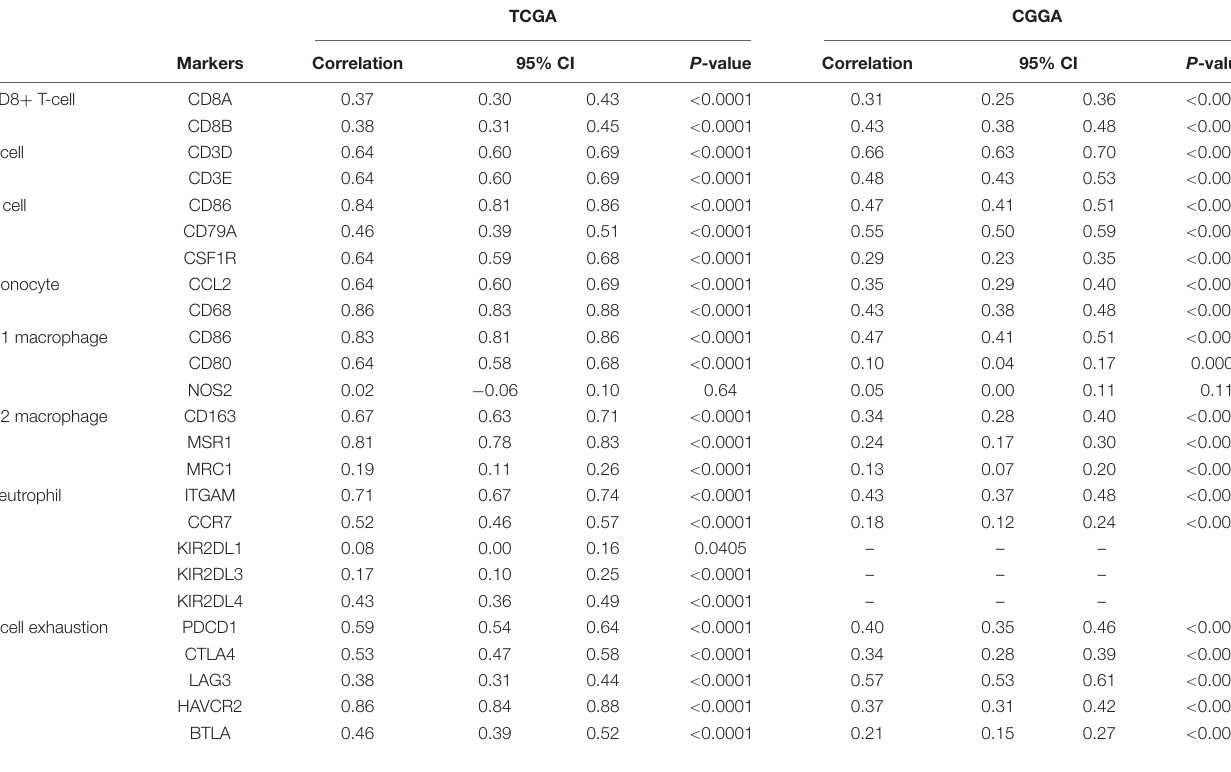
TABLE 3 | Correlation between GMFG expression and markers of immune cells in TCGA and CGGA